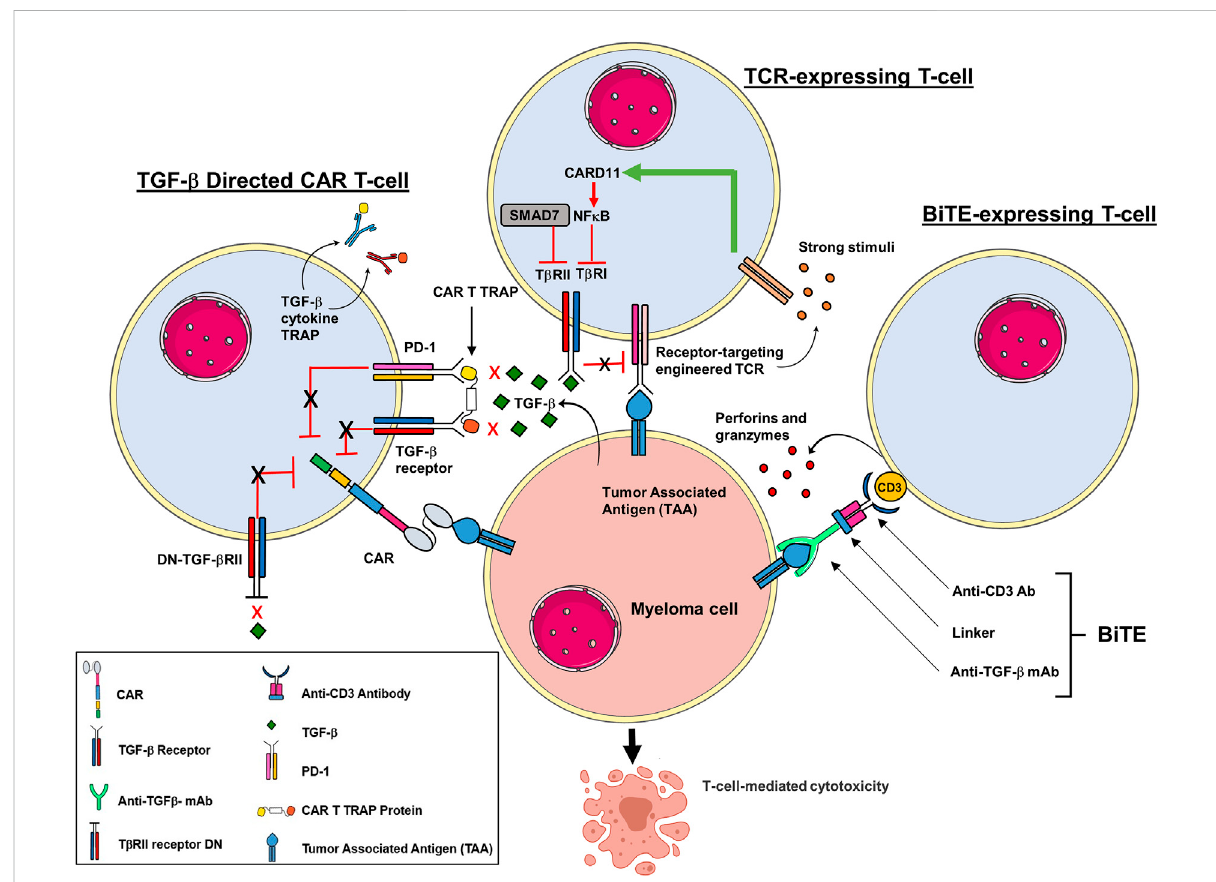
FIGURE 2 Adoptive T cell strategies to prevent immune suppression by TGF- β in TME. Multiple strategies are in development to modify T cells to target components ofthe TGB- β signaling pathway. Tcells can beengineered to work against theimmunosuppressive role of TGF- β , activated to induce a moreef fi cientTcellcytotoxicityandpreventexhaustion.CARTcellshavebeenengineeredtoblocktheinhibitoryeffectsofTGF- β byco-expressing a BCMA construct that expresses a dominant negative (DN) TGF- β RII armor. The DN TGF- β II lacks a functional receptor kinase domain which prevents TGF- β suppression despite prolonged exposure. CAR T cells have also been modi fi ed to express a decoy or a cytokine receptor that functionally converts inhibitory signals within the TME into pro-in fl ammatory signals. In addition, CAR T cells have been engineered to secrete